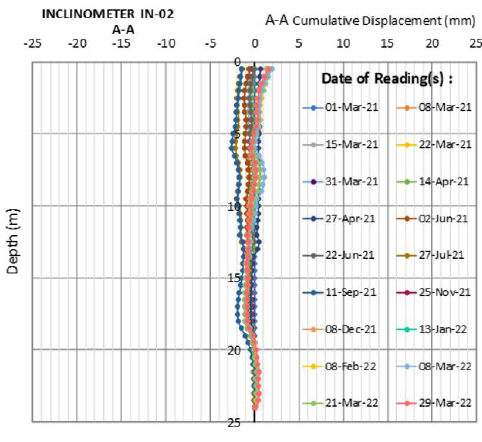
Figure 13. Inclinometer reading IN-01.